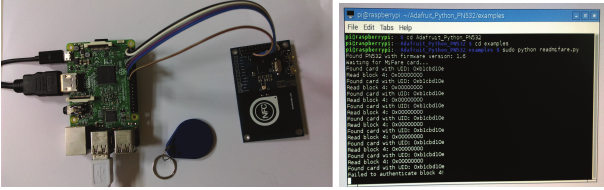
Figure 11. The stop-requested unit of a bus stop: an example of a stop-requested unit at a bus stop ( left ), which is responsible for analyzing the intentions of boarding the bus ( right